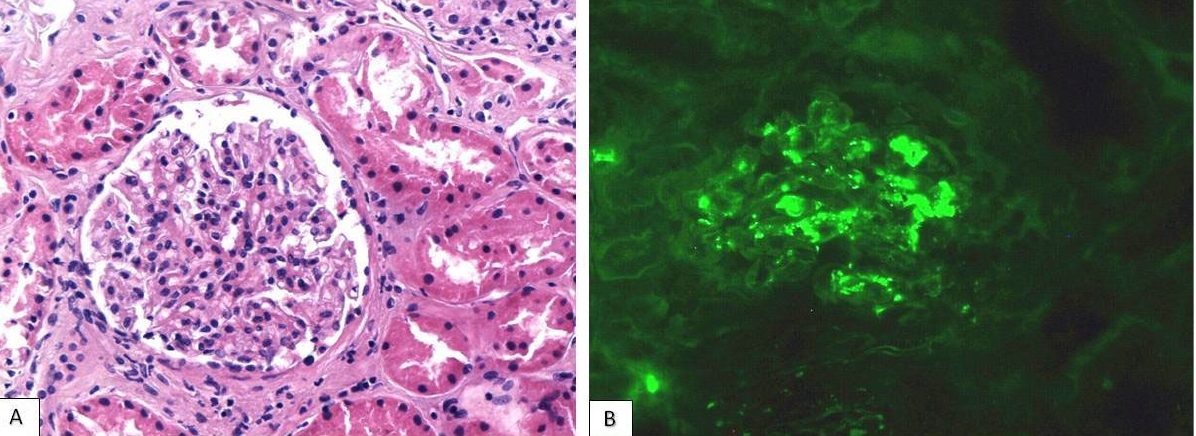
Figure 3. IgA glomerulonephritis with mild mesangial hypercellularity and mesangial matrix expansion (( A ): HE ×200). Immunofluorescence shows strong mesangial deposition of IgA immunoglobulin (( B ): IgA ×200).